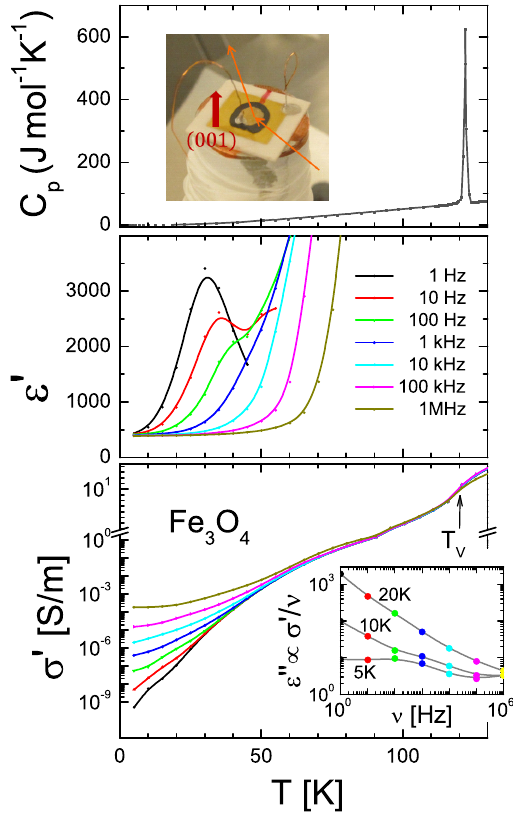
Figure 2. Temperature dependence of physical properties of the magnetite crystal. Top: Specific heat, with a narrow (FWHM ∼ 0.85K) peak at T V = 122K. The inset shows a photo of the crystal with gold contacts mounted for the diffraction experiment. Middle: Dielectric permittivity ε (cid:48) over 6 decades of frequencies. Bottom: Conductivity for the same frequencies. The inset shows the imaginary part of the permittivity as a function of frequency at selected temperatures. Lines in the middle and bottom panels are